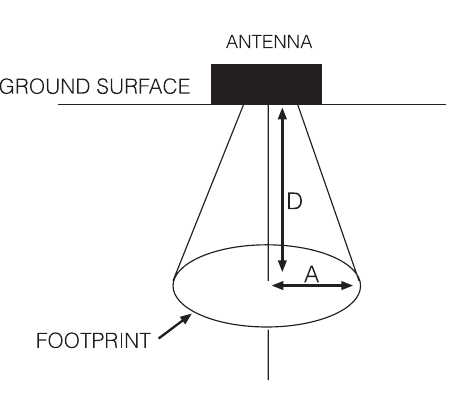
Fig. 2. The elliptical cone of GPR into the ground (from Conyers and Goodman,